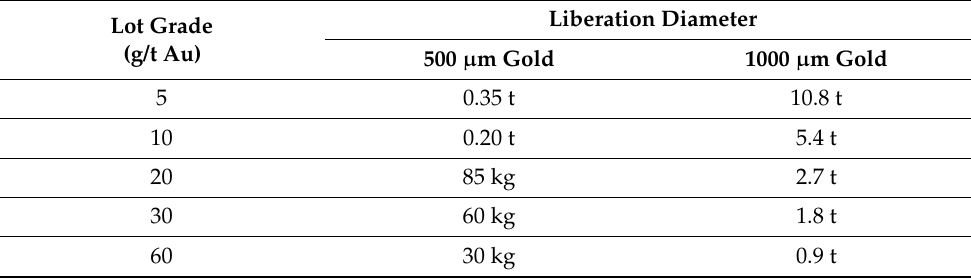
Table 11. The FSE-optimised sample mass for a fine- and coarse-gold ore, based on achieving a precision of ± 15% at the 90% confidence limits. The residue top size is taken as 5 cm. Liberation Diameter Lot Grade (g/t Au) 500 µ m Gold 1000 µ m Gold 5 0.35 t 0.20